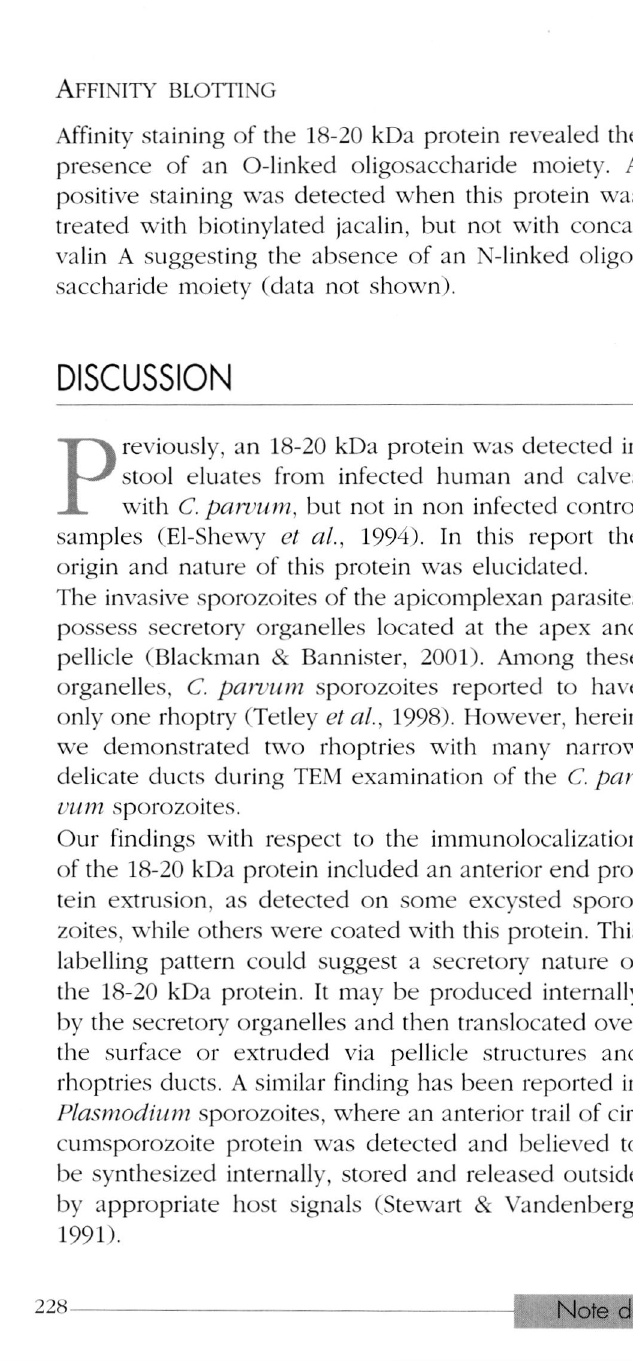
Fig. 3 - (A) Immunoelectron micrograph of excysted and completely released C. parvum sporozoite, reacted with mono specific anti-18-20 kDa antibody, demons trating gold particles clustered on the conoid (Co) concentrated and distributed over the membrane pellicle (Mp) and for ming a trail in front of the released spo rozoites (S). Note electron-lucent vacuole (V) and micronemes (Mn), with many whorls, x 24.000. (B) Scanning immunoelectron micrograph of C. parvum excysted and released spo rozoite, reacted with monospecific anti-18- 20 kDa antibody, showing gold particles coating the entire sporozoite surface (cir- cumsporozoite), and in front of the spo rozoite (S), x